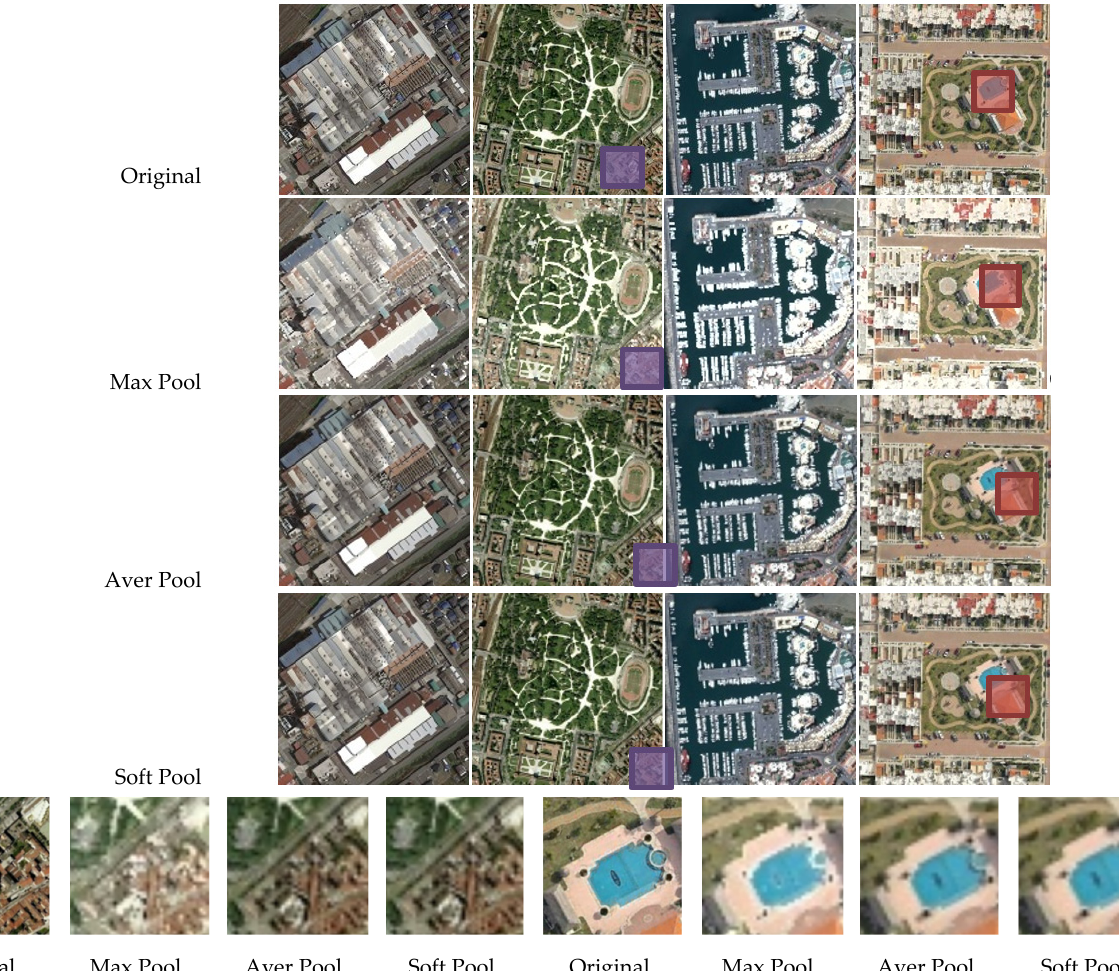
Figure 8. The effects of different pooling methods. The bottom row is the zoom area of the above image. The natural exponent ( e ) is adopted to ensure that the larger the energy value